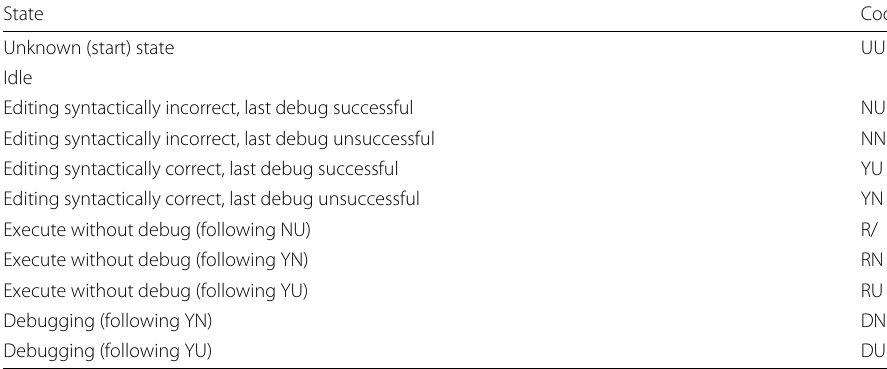
Table 2 The 11 states in the transition diagram State